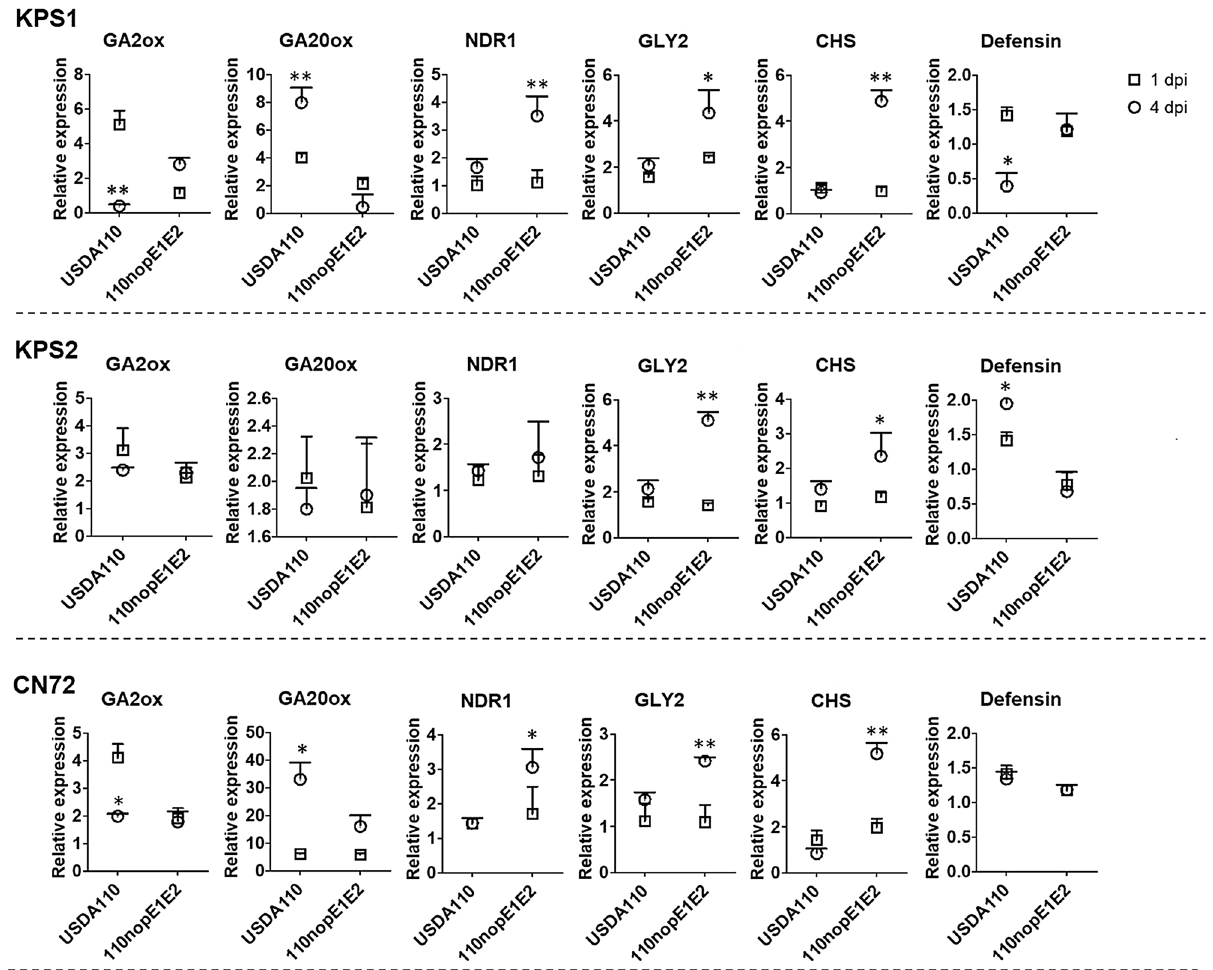
Figure 6. qRT-PCR analysis data for Vigna radiata cv. (KPS1, KPS2, and CN72) between USDA110 and 110nopE1E2 inoculations at 1 dip and 4 dpi. The expression levels of genes that were differentially expressed in KPS1, including gibberellin 2 oxidase ( Ga2ox ), gibberellin 20 oxidase ( GA20ox ) nondisease resistance 1 ( NDR1 ), glycerol-3-phosphate dehydrogenase ( GLY2 ), chalcone synthase ( CHS ), and plant defensin ( PDF ), were determined. Significance at P < 0.05, “*”and P < 0.01, “**”according to Student’s t